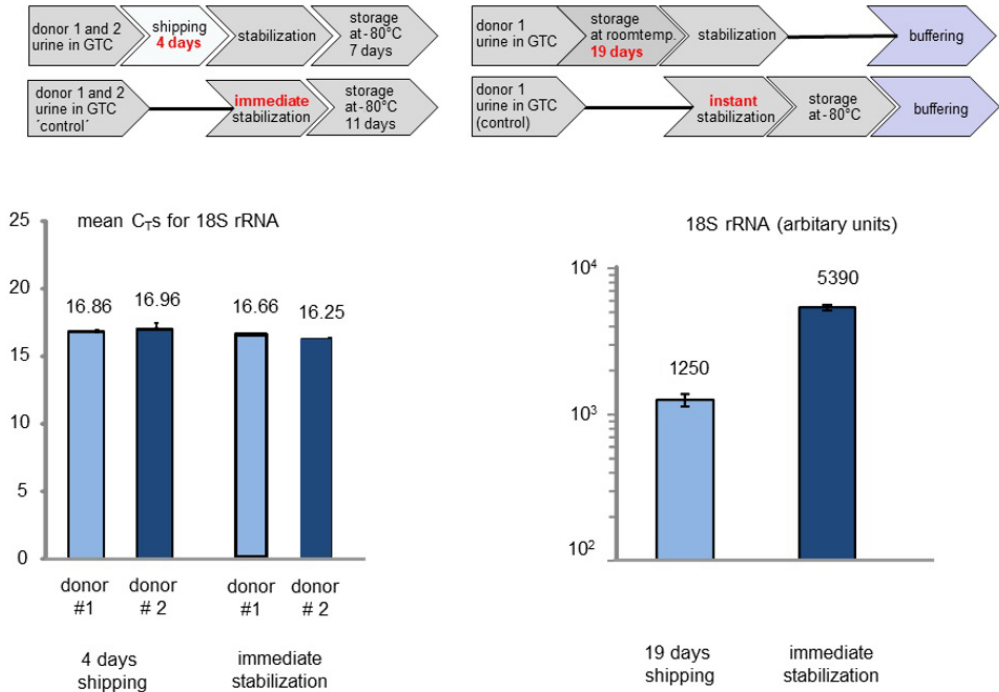
Figure 4. Influence of 4-days and 19-days storage at room temperature or shipment temperature, respectively, on the detectability of 18S rRNA. We included two donors, performed two independent RNA isolations for each donor and two RT-qPCR reactions per RNA preparation. After storage at − 80 ◦ C all samples were buffered which is indicated for the 19-days data (upper right